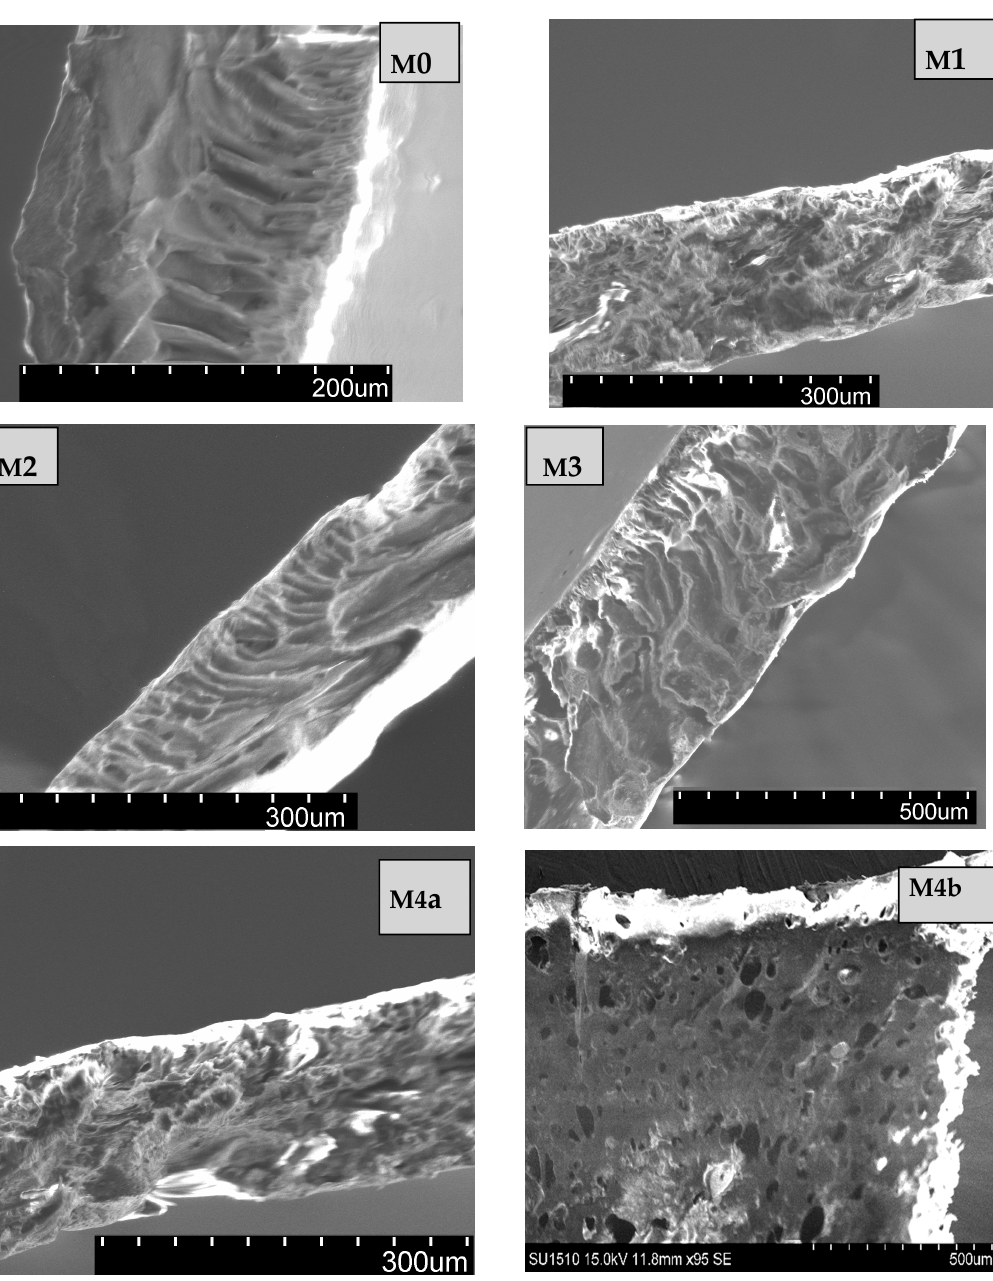
Figure 3. SEM images ( a ) and TEM images ( b ) of the selected KIT-6 sample. A high percent of smaller spherical particles was obtained at higher temperature.